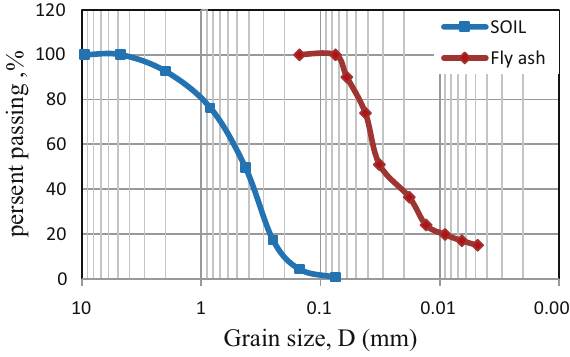
Figure 1: Grain size distribution curve of sand and FA.